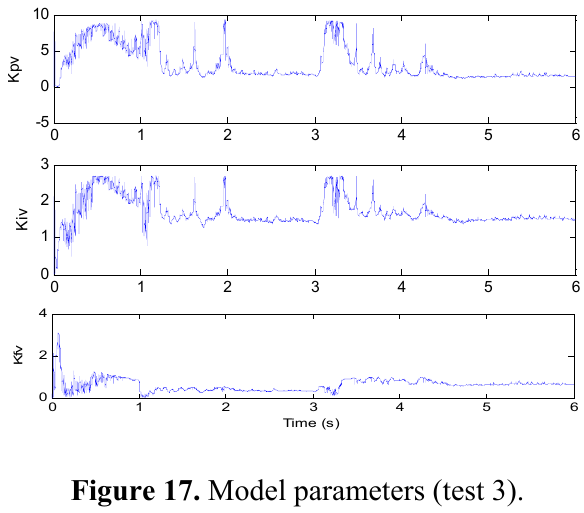
Figure 17. Model parameters (test